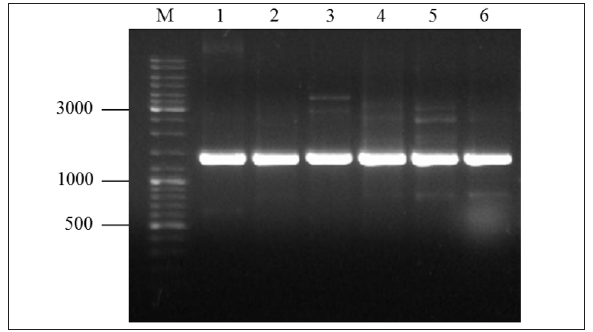
Figure 2: Agarose gel electrophoresis analysis of 16S rRNA genes amplified from six bacterial isolates. PCR amplified products were run on 1% agarose gel. Lane M indicates the DNA ladder (O’GeneRuler DNA Ladder Mix 100–10 000 base pair, catalogue number SM1173, ThermoFisher). Markers with high intensity were indicated by their size. Lanes 1 to 6 indicate the PCR amplified 16S rRNA gene of the respective bacterial isolates.